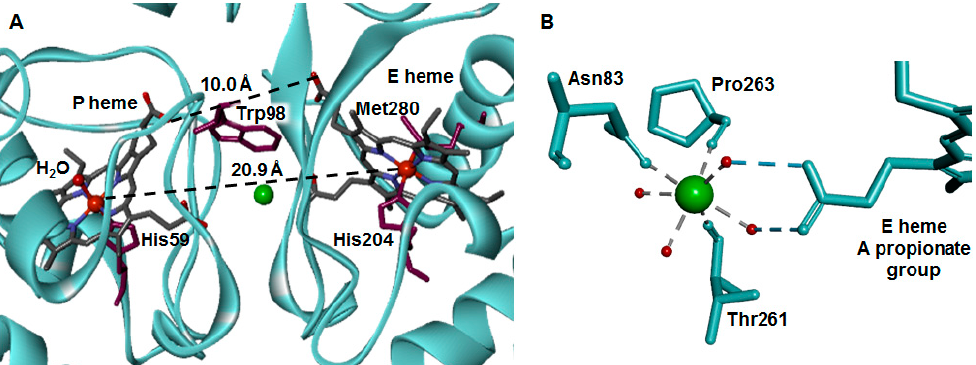
Figure 4. View of the mixed-valence Ng BCCP structure and calcium binding site. In ( A ) is shown the calcium ion (green sphere) located between the two hemes, the His/Met 6-coordinated E heme and the P heme coordinated by a proximal histidine residue and a distal water molecule (small red sphere). Although the two hemes have a Fe-Fe distance of 20.9 Å, electron transfer is possible because of the tryptophan residue located between their propionate groups. In ( B ) is shown the calcium binding site. The calcium ion (green sphere) is coordinated by the oxygens of four water molecules (small red spheres) and three conserved residues (Asn83, Thr261 and Pro263). This view also shows that the calcium ion is near the carboxylate group of the E heme propionate A, which forms hydrogen bonds with two of the coordinating water molecules. Figures prepared with BIOVIA Discovery Studio Visualizer 4.5.